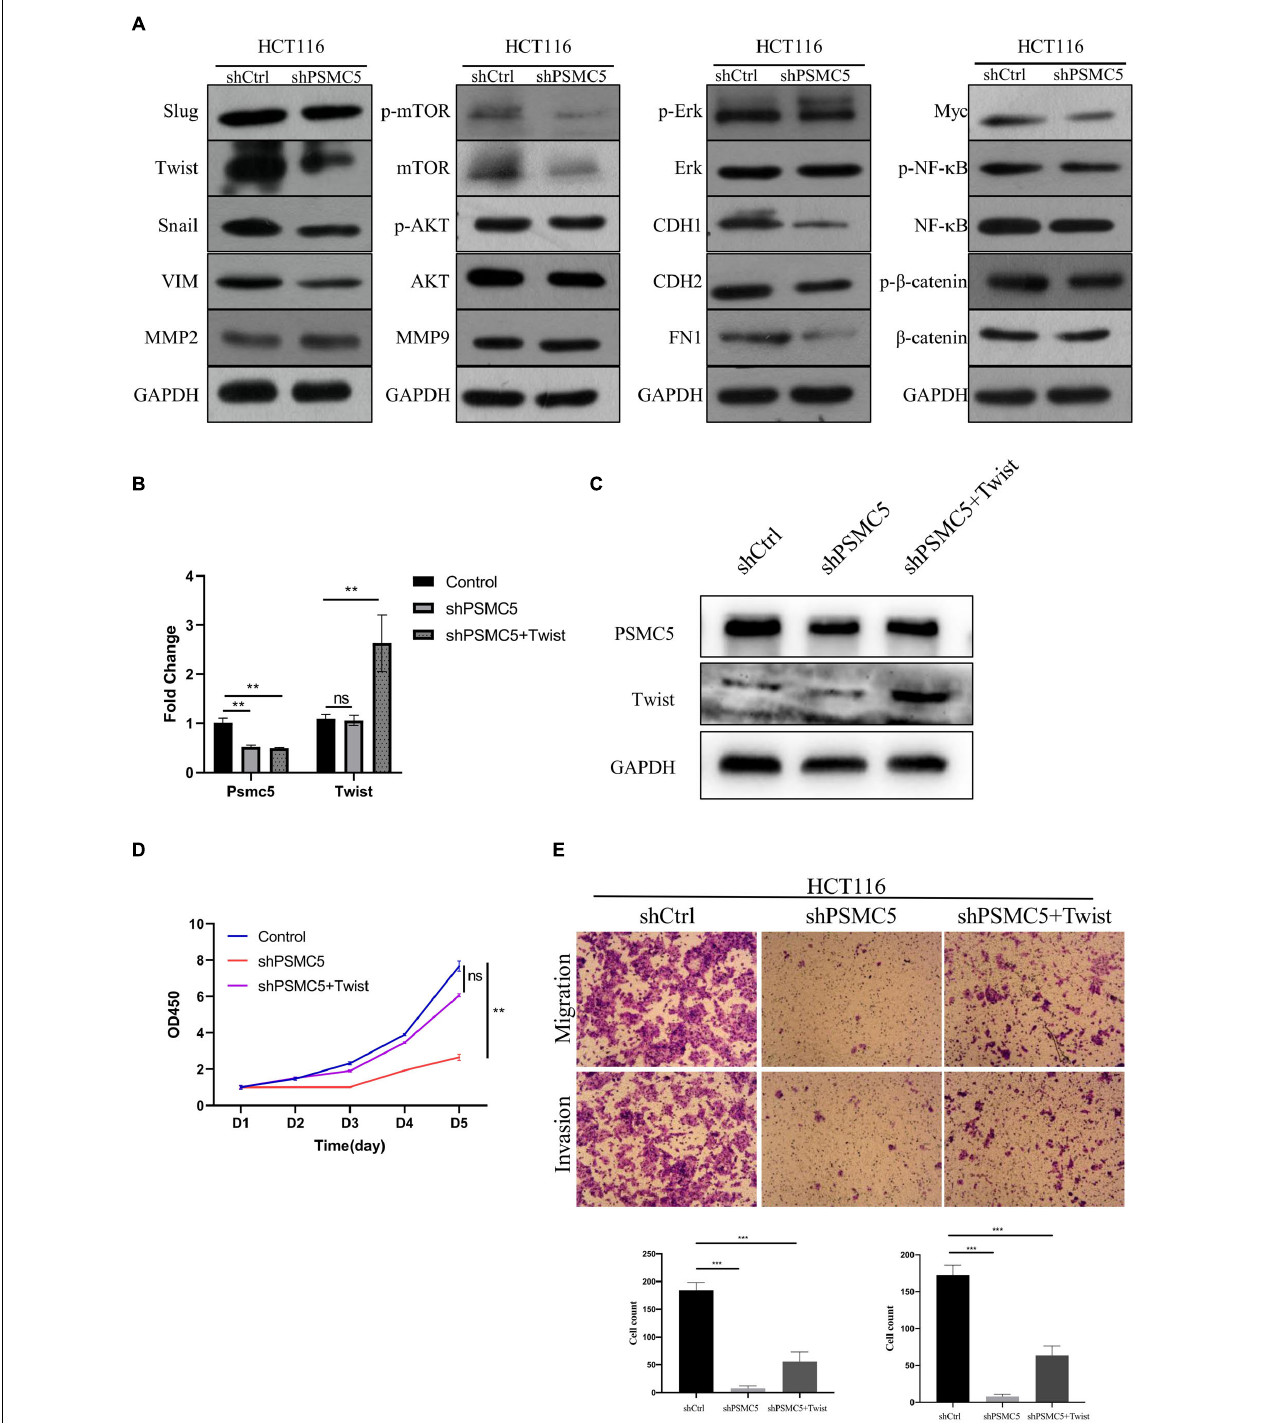
FIGURE 5 | PSMC5 promoted epithelial–mesenchymal transition of CRC cells by upregulating Twist . (A) Western blotting panel containing key components of EMT was designed to screen the potential targets of PSMC5. Twist with the max fold change was selected for further research. (B,C) RT-PCR (B) and Western blotting (C) confirmed and validated co-transfection of Psmc5 and Twist . Student’s t -test was used to measure the difference of target RNAs between control and transfected cells. ** p < 0.01. (D,E) MTT assay (D) and transwell assay (E) showed that impaired cell growth and invasion could be rescued by ectopic expression of Twist . One-way ANOVA test was applied to calculate the difference of cell growth across three groups. Ns, not significant. ** p < 0.01. CRC, colorectal cancer; EMT, epithelial–mesenchymal transition. *** p < 0.001.